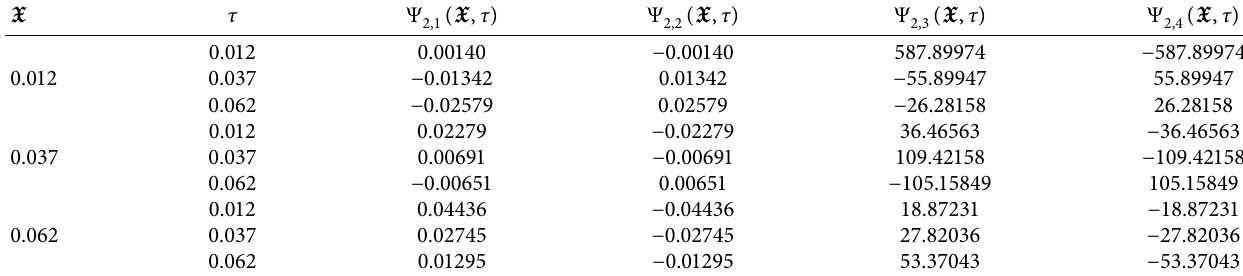
Table 4: The imaginary part of exact solutions of CTFMNLSE (1) obtained by the MTEM with several point sources through